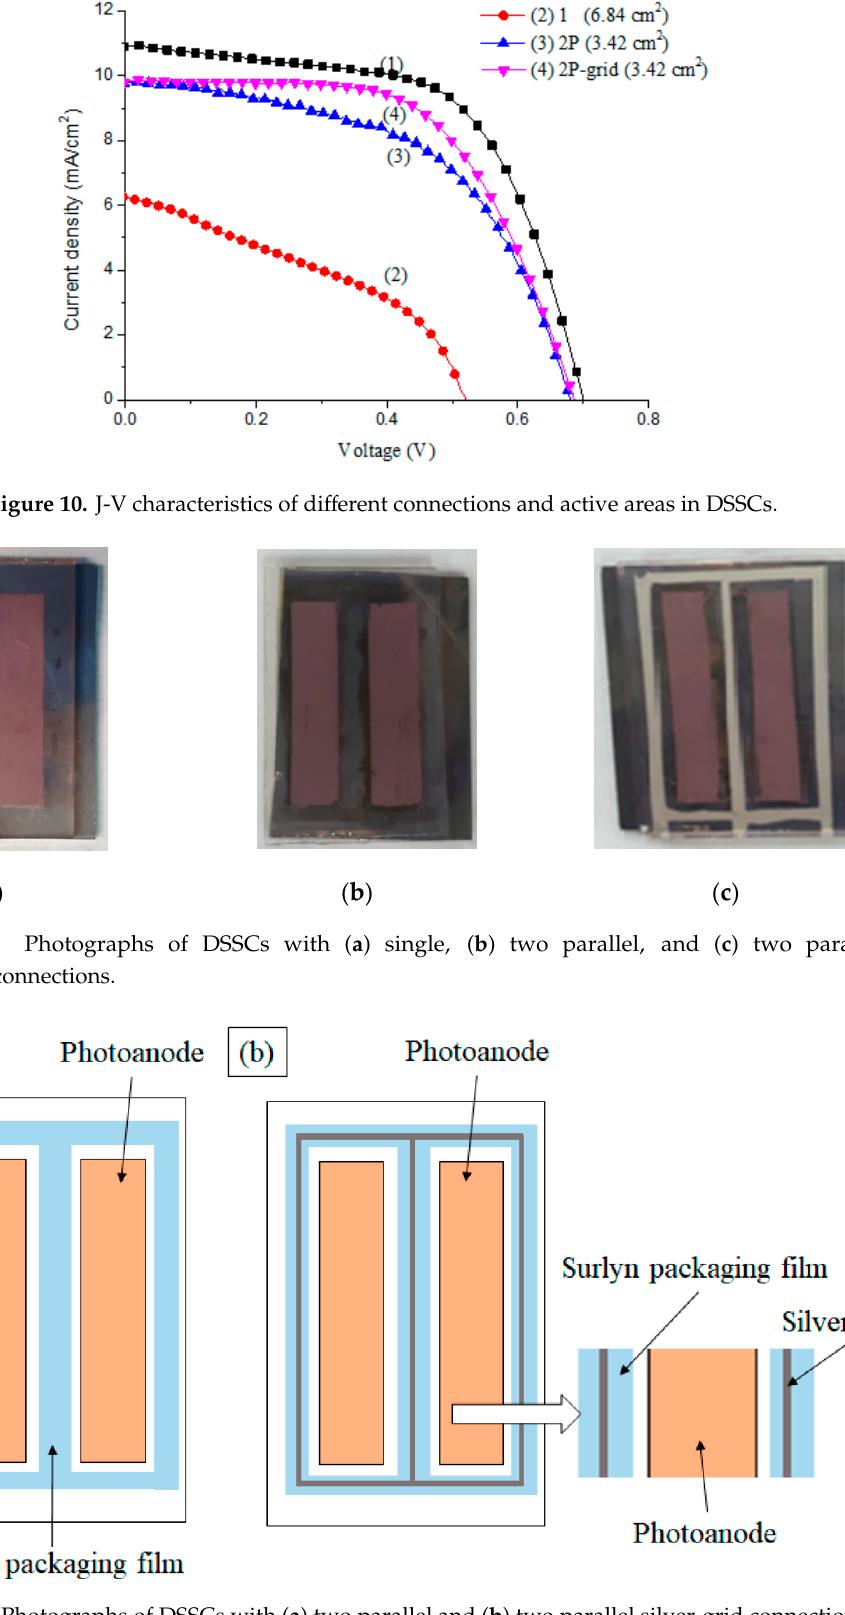
Figure 12. Photographs of DSSCs with ( a ) two parallel and ( b ) two parallel silver-grid connections.